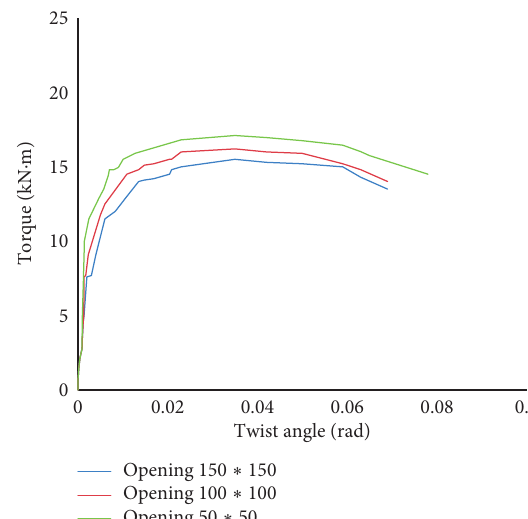
Figure 10: Torque-twist angle relationship of square hollow cross- section.